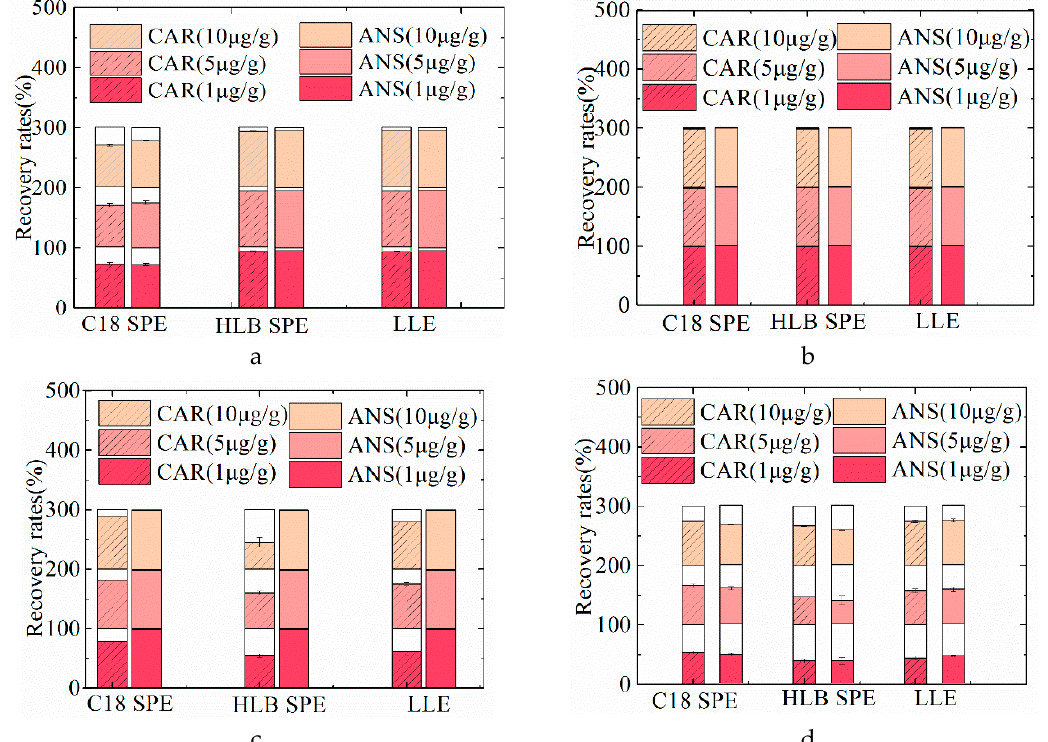
Figure 2. The recovery rates of CAR and ANS spiked with different concentrations (1, 5, and 10 µg/g) of standards using different extraction procedures (C18 solid-phase extraction (SPE), HLB SPE, and liquid-liquid extraction (LLE) procedures) in porcine ( a ), poultry ( b ), bovine ( c ), and ovine ( d ) MBM samples.